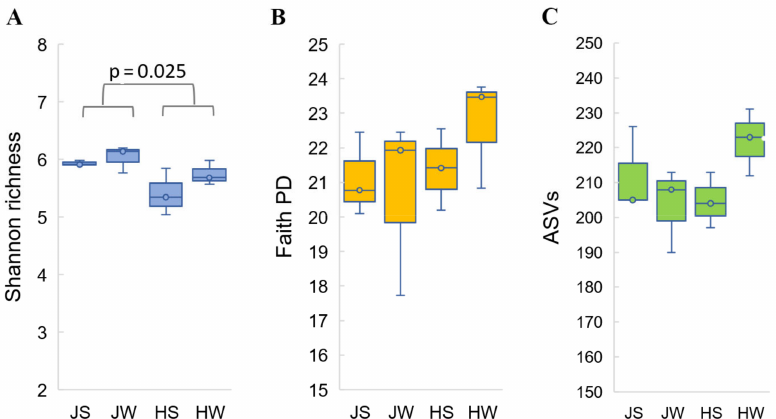
Figure 1. Alpha diversity analysis of Jamaican and house cricket’s bacterial microbiota based on Shannon index ( A ), phylogenetic diversity Faith’s PD index ( B ), and observed ASV index ( C ). Sam- ples were rarefied to sampling depths of 40,000. Kruskal–Wallis test was performed to analyze statistical significance. Table 2. Beta diversity analysis based on both weighted and unweighted UniFrac distance met- rics. JS—Jamaican cricket surface, JW—Jamaican cricket whole body, HS—house cricket surface, HW—house cricket whole-body samples. Unweighted